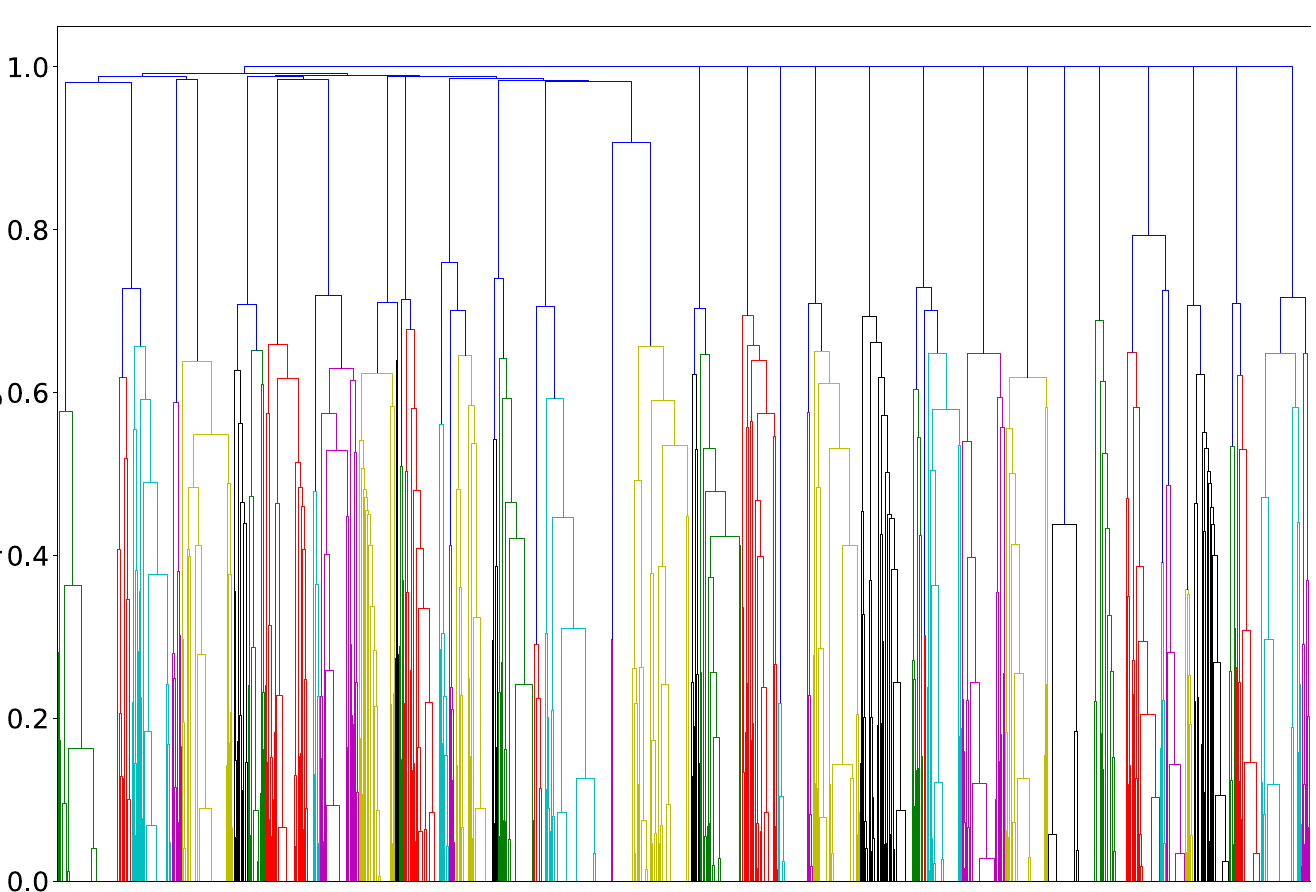
Fig 8. Illustrating the full dendrogram result of agglomerative hierarchical clustering employed on news